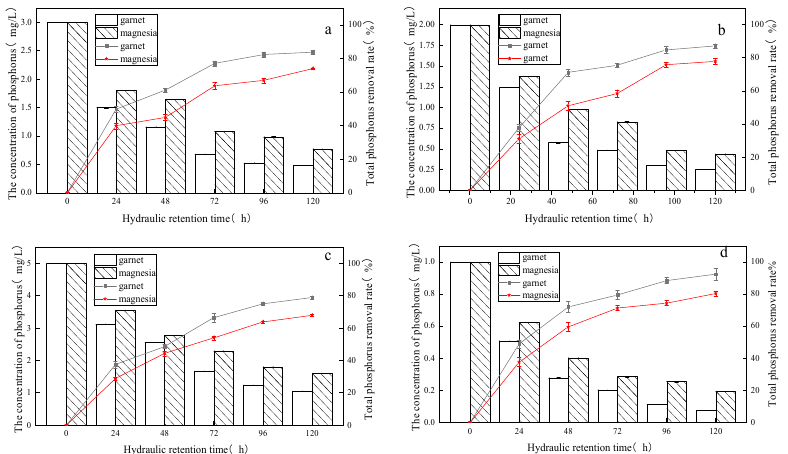
Figure 1. Total phosphorus concentrations and removal rates. ( a ) 1 mg/L; ( b ) 2 mg/L; ( c ) 3 mg/L; ( d ) 5 mg/L.